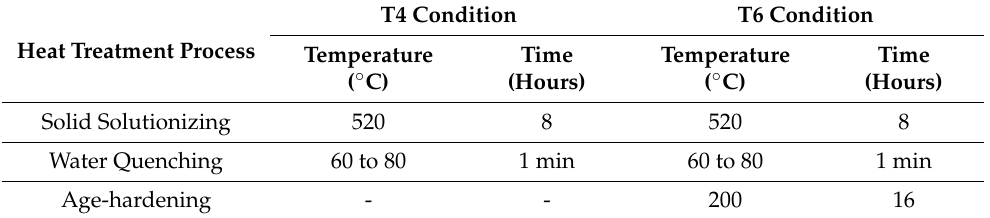
Table 2. Details of heat-treatment